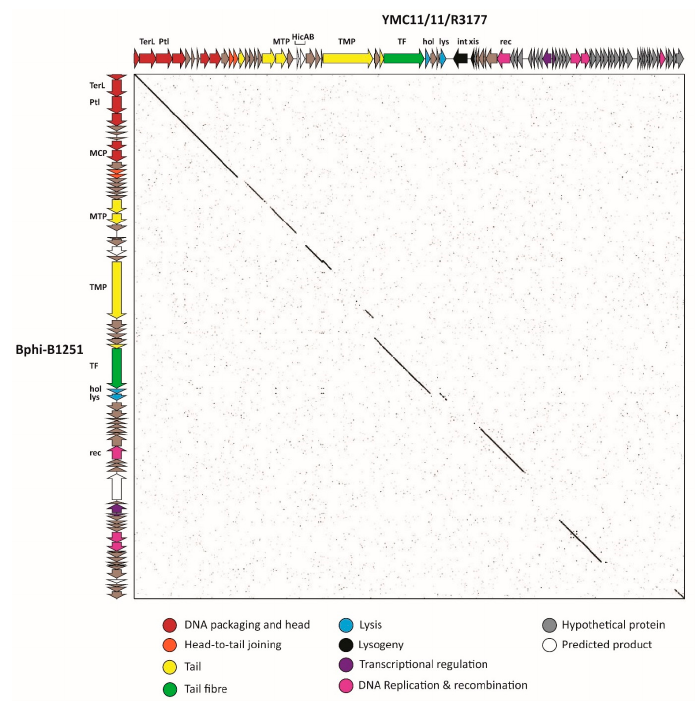
Figure 7. Dot plot comparison of the nucleotide sequences of Acinetobacter phages YMC11/11/R3177 and Bphi-B1251 illustrating breaks in syntenic similarity. Genome maps are displayed on the horizontal and vertical axes. Genes identified by bioinformatics analysis as belonging to specific modules are color-coded according to the key. Selected genes are annotated in the figure: TerL, large subunit terminase; Ptl, portal vertex protein; MCP, major capsid protein; MTP, major tail protein; TMP, tape measure protein; HicAB, HicAB toxin-antitoxin; hol, holin; lys, lysin; int, integrase; xis, excisionase; rec, putative RecA-like recombination protein. The figure was constructed using Gepard and EasyFig and edited using Adobe Illustrator.